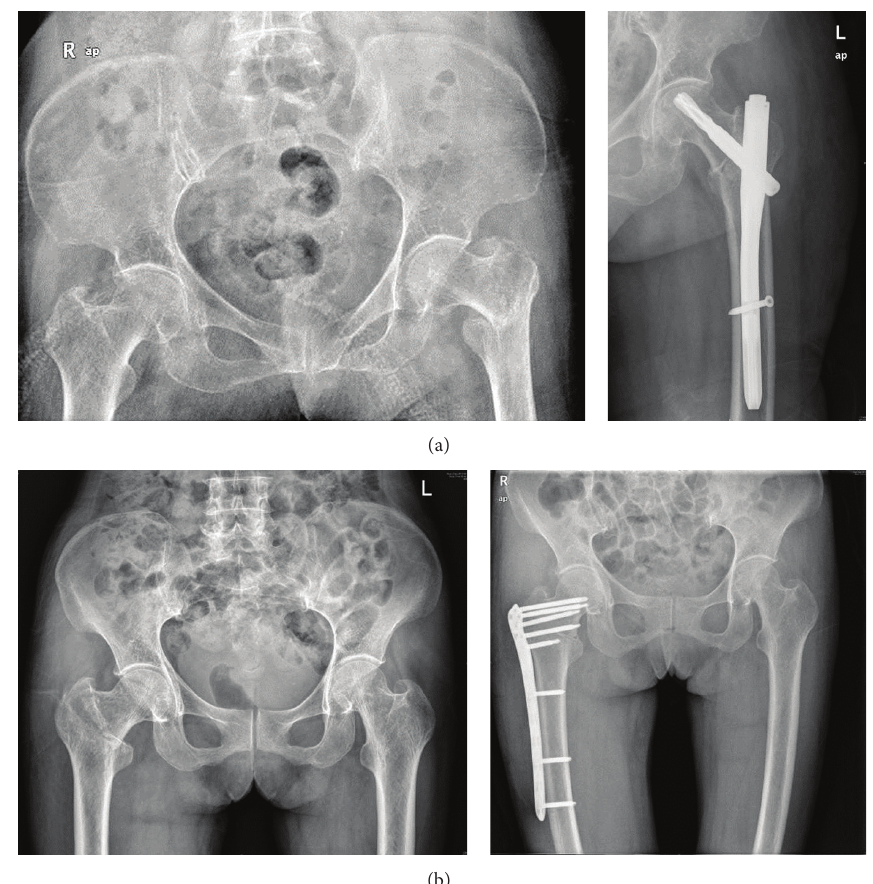
Figure 1: Patients with 31 A1 fractures. (a) PFNA: preoperative AP view and immediate postoperative AP view. (b) Reverse LISS: preoperative AP view and immediate postoperative AP